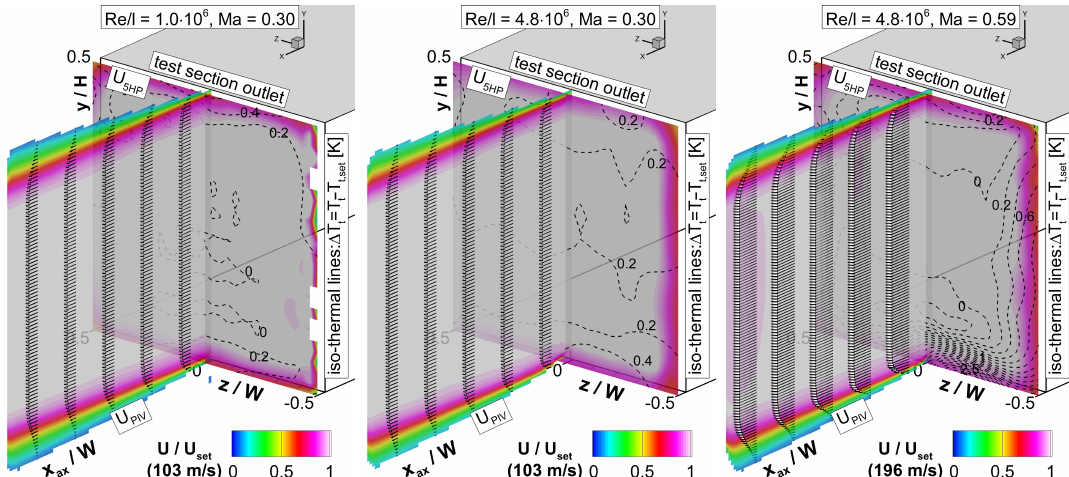
Figure 10. Outflow topology at the HGK’s test section outlet measured with 5-hole probe, stereo-PIV and a total temperature probe for Re / l = 1 × 10 6 m − 1 at Ma = 0.30 ( left ), Re / l = 4.8 × 10 6 m − 1 at Ma = 0.30 ( middle ) and Re / l = 4.8 × 10 6 m − 1 at Ma = 0.59 ( right ). The dashed iso-thermal lines show the local difference in the flow temperature according to the total temperature setting T t = 30 ◦